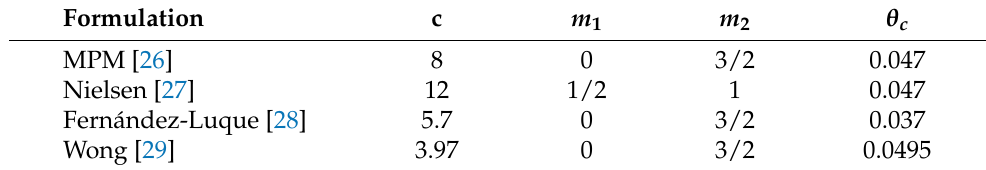
Table 1. Coefficients c , m 1 , m 2 , and θ c for different capacity solid transport rate formulations (9).